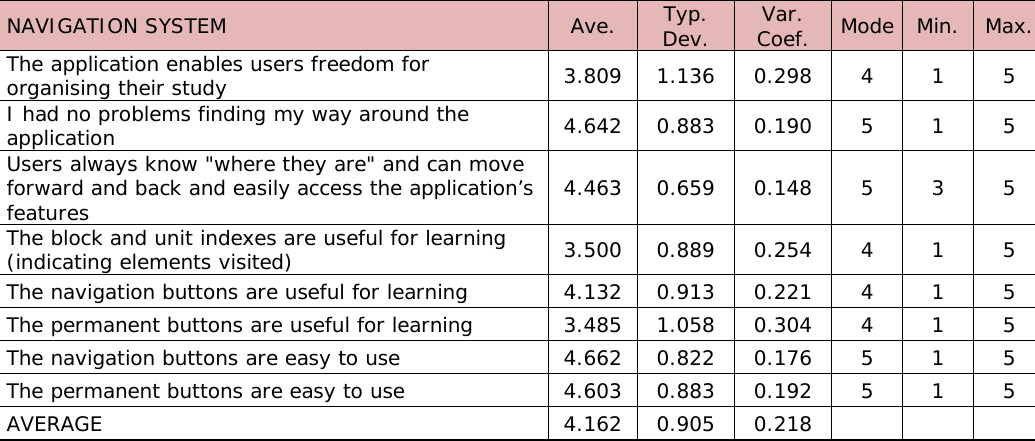
Table 3. “Assessment of Navigation